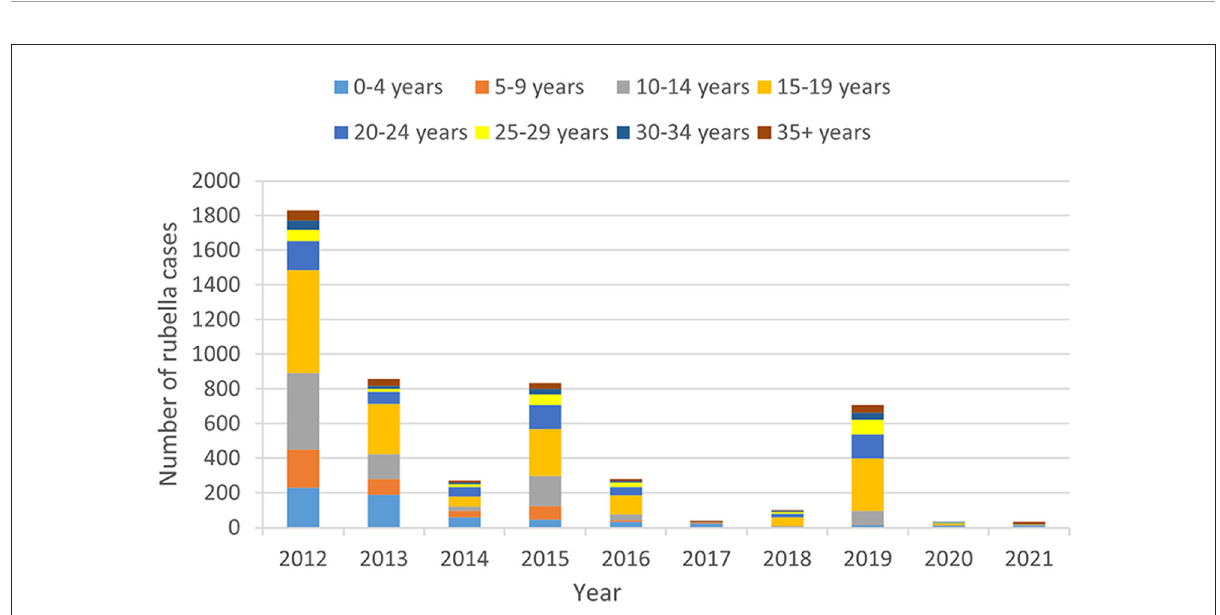
FIGURE3 Rubella cases age distribution in Anhui province from 2012 to 2021.